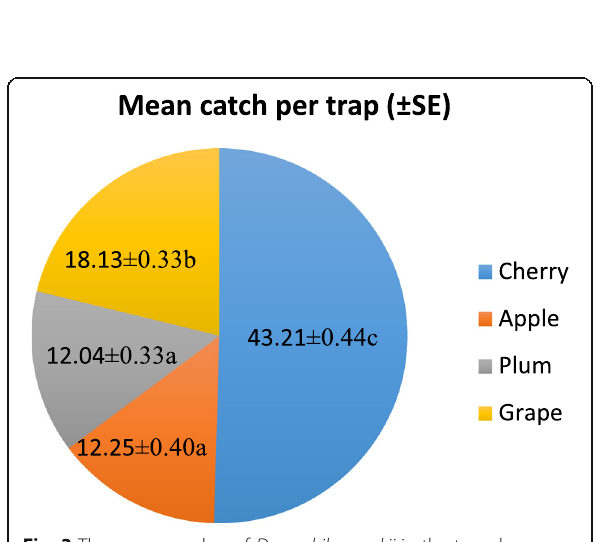
Fig. 3 The mean number of Drosophila suzukii in the traps hung on the fruit trees in Ba ğ konak village in 2018. The difference between the averages with the same latter is not statistically significant (Tukey p ≥ 0.05) ( N =